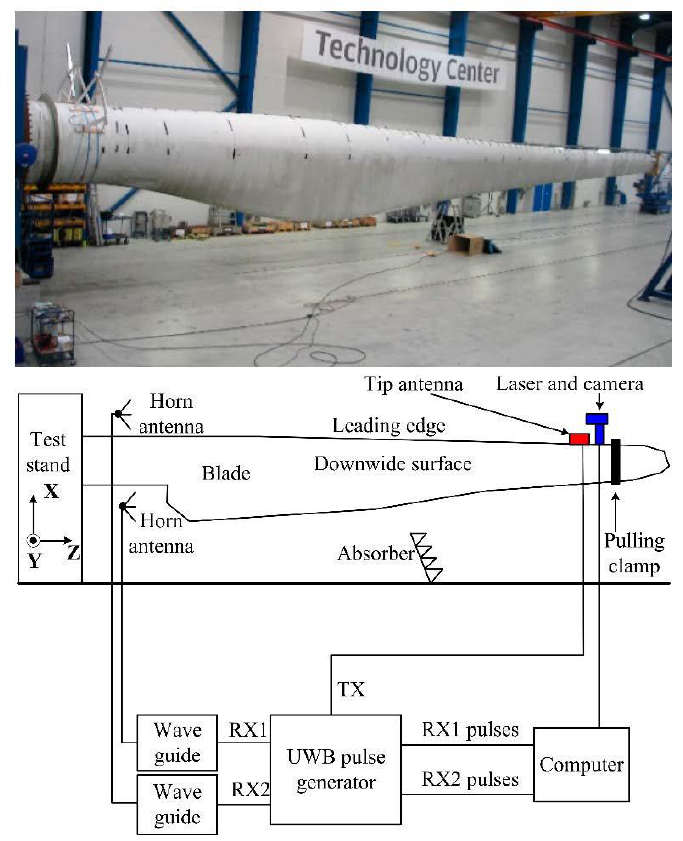
Figure 2. Test system